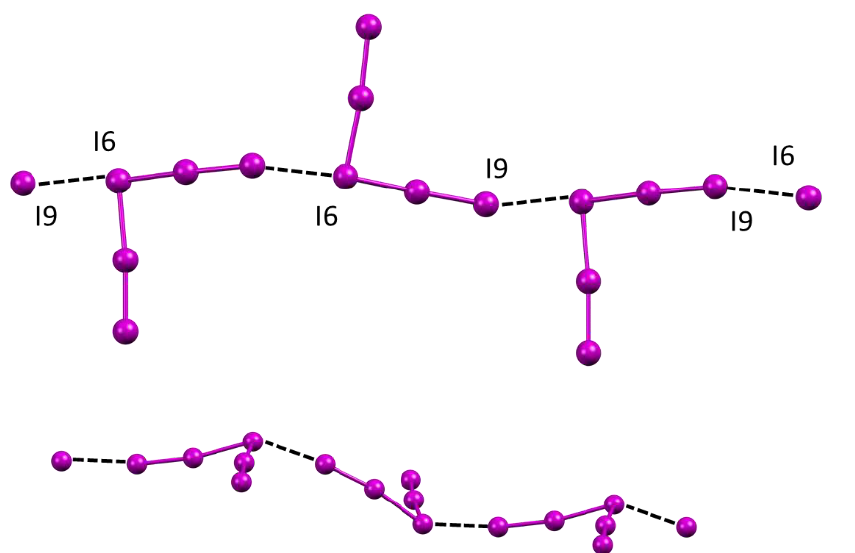
Figure 9. Views of the pentaiodide infinite chain linked through the I9 ⋯ I6 halogen bond. Accordingly, while the global polyiodide arrangement of the polyiodide network is layered, in the present case intralayer I-I interactions amount to a single I · · · I contact per pentaiodide, reducing the possibility of tighter packing and overall iodine